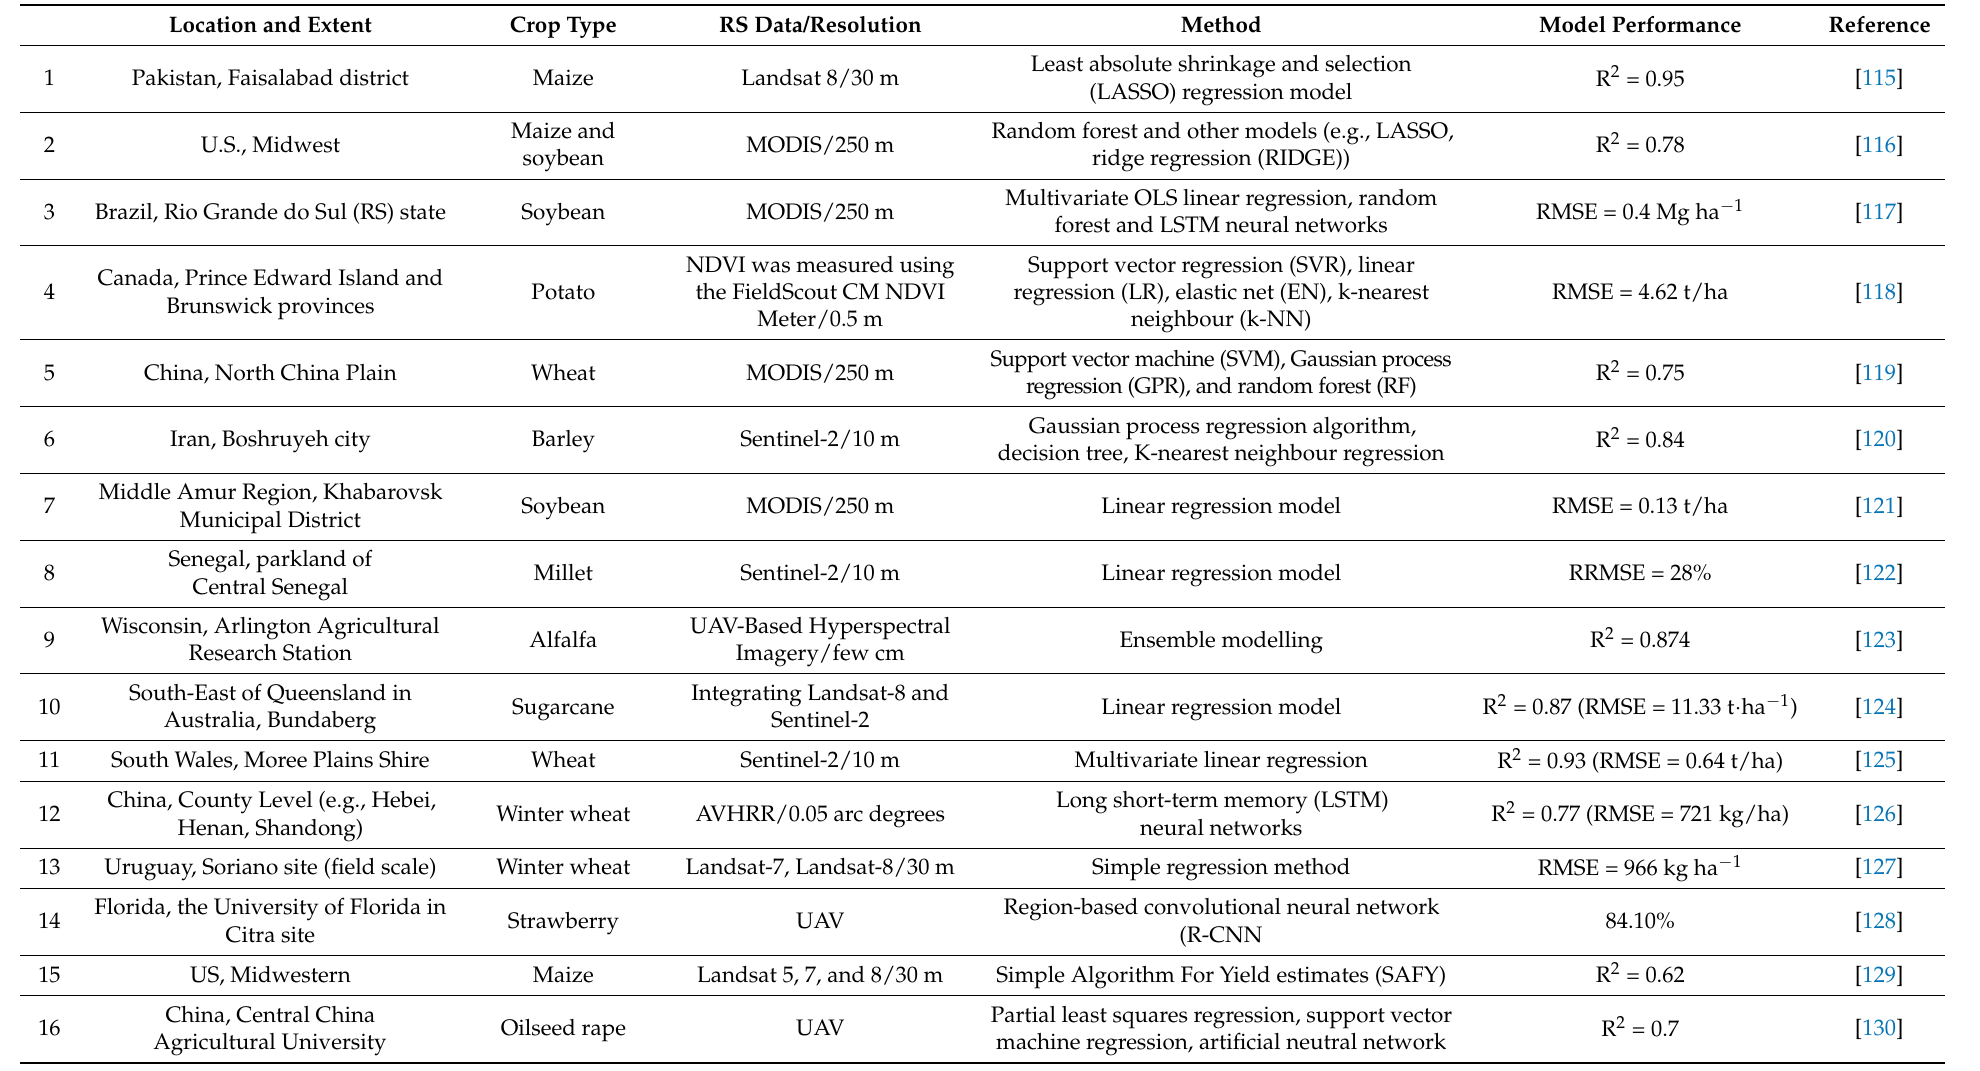
Table 2. Summary of relevant papers using RS data to predict yield for different crop